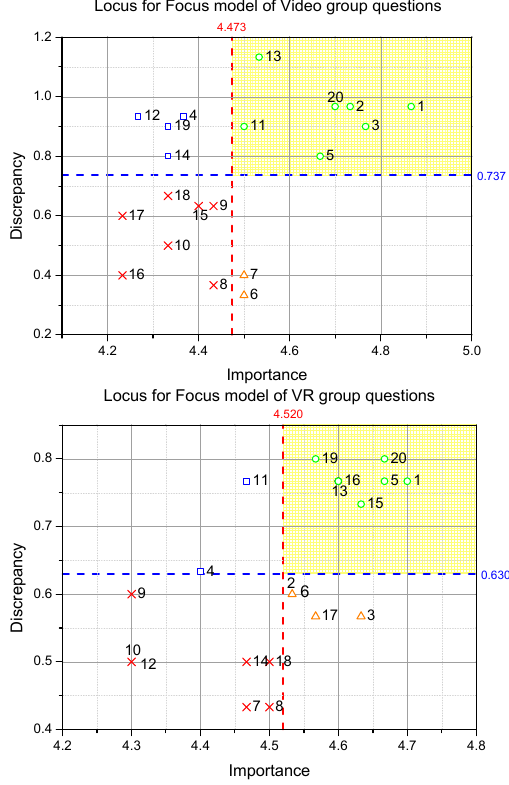
Figure 7. Locus for focus model for video (up) group and VR group (down). Meaning of symbols: ○ : HH, △ : HL, □ : LH, ＊ : LL.